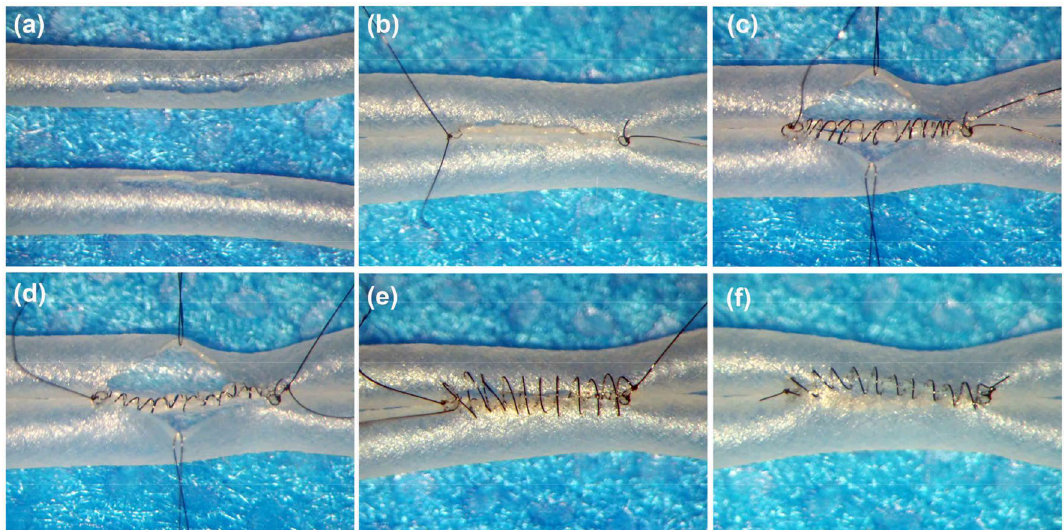
Figure 2. Side-to-side anastomosis by using silicone tube. Longitudinal incisions of approximately three times the diameter of the silicone tube were made on both silicone tubes ( a ). Two 10–0 anchoring sutures were placed at opposite ends of the anastomoses ( b ). The posterior wall was closed intraluminally in a loose continuous suturing fashion ( c ) and these sutures were tightened ( d ). The anterior wall was closed extraluminally in a loose continuous suturing technique ( e ) and these sutures were tightened ( f ).